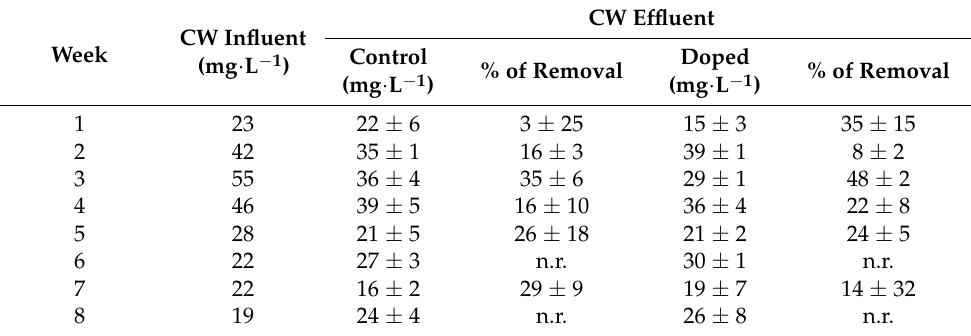
Table 3. Concentration of COD (mg · L − 1 water) in CWs influents and effluent (mean ± standard deviation, n = 3) and percentage of removal (%, mean ± standard deviation, n = 3) for eight weeks. n.r. means that there was no COD removal in the